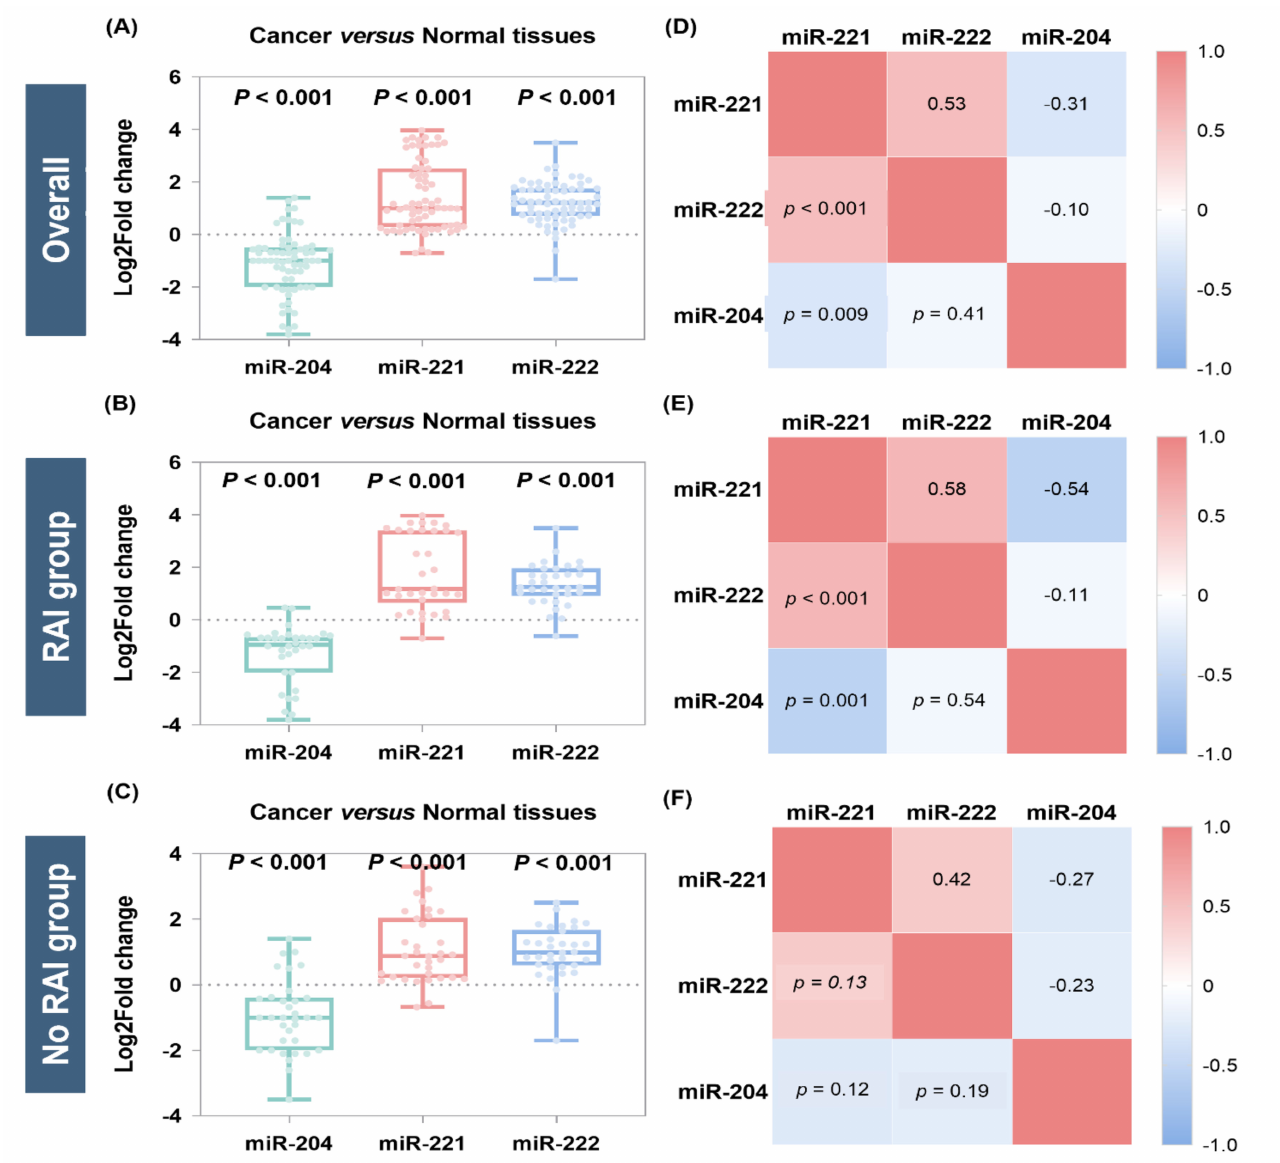
Figure 3. Relative expression of microRNAs in thyroid cancer tissues compared to paired counterparts. The plot represents overall analysis for the 68 patients and subgroup analysis for the 34 RAI and 34 non-RAI groups. ( A – C ) Box plots show the median and interquartile range in cancer. Log2 fold change below 0 indicates downregulation, while greater than 0 indicates overexpression compared to normal. Wilcoxon matched-pairs signed-rank test was used for comparison. Significance was set at p -value < 0.05. ( D – F ) Correlation matrix for gene co-expression. Spearman’s correlation analysis was performed. The correlation coefficient ( − 1 to 1) is presented in the top right of the matrix, and its equivalent p -value is in the bottom